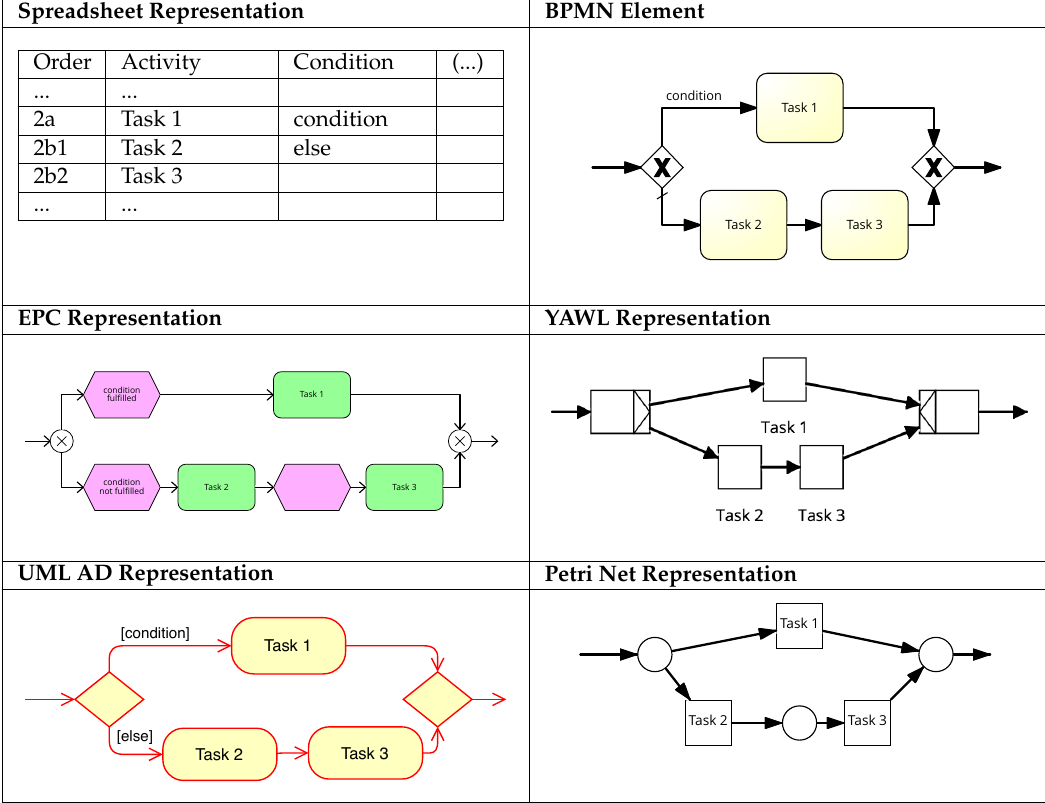
Table 10. XOR-gateway